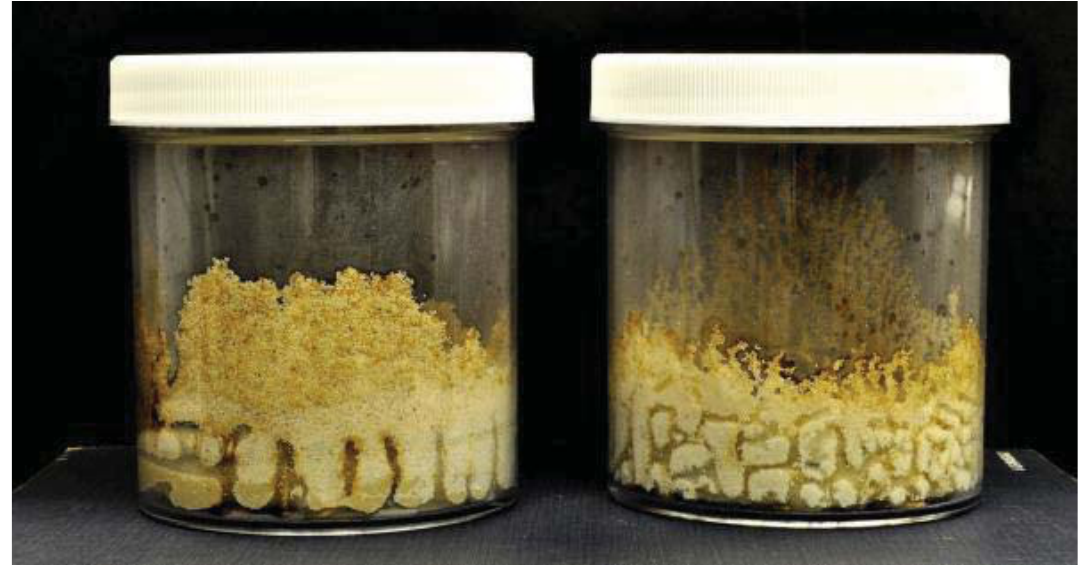
Figure 2. Tunneling patterns of C. formosanus ( left ) and C. gestroi ( right